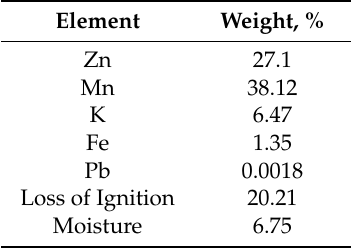
Table 2. Battery paste analysis.